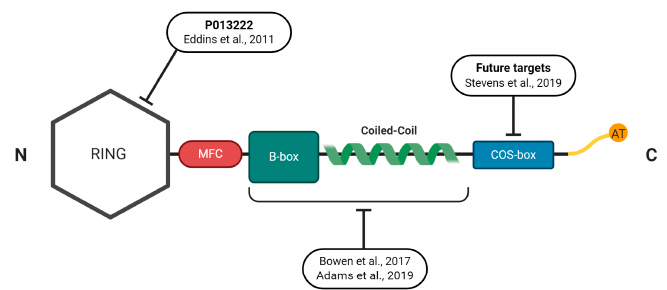
Figure 2. Schematic representation of MuRF1 (cid:48) s protein structure indicating the regions that have been, or could be, exploited for small molecule inhibition alongside the relevant study reference. See the main text for full